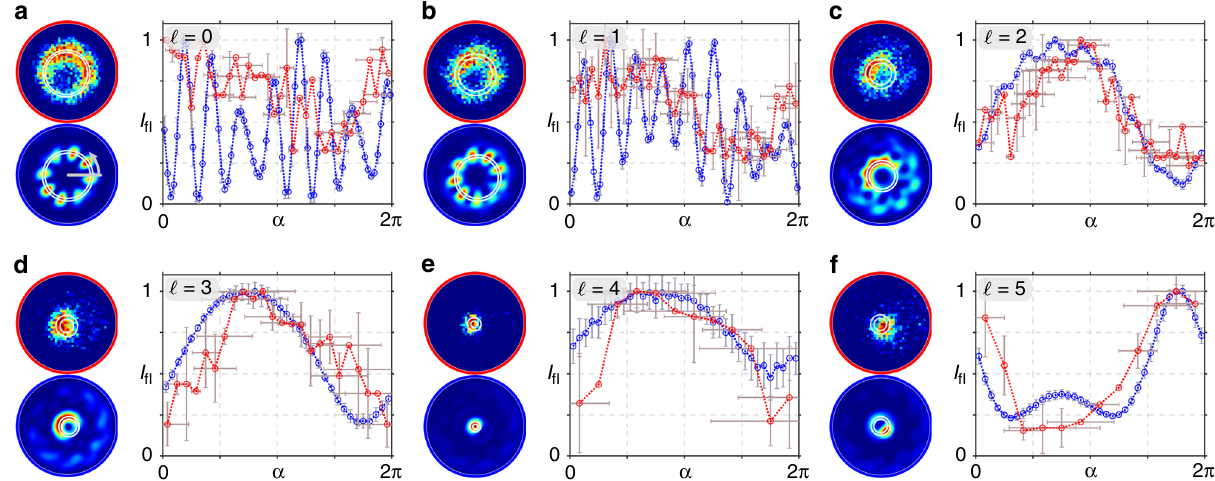
Fig. 7 Graphical analysis of fl uorescence for focused web con fi gurations. a – f σ 12 = − 8, ‘ ¼ f 0 ; 1 ; ¼ ; 5 g . Studied intensity images are shown to the left of each graph (experiment: red edged, simulation: blue edged). In graphs, the mean intensity I fl in an angular segment of a ring shaped subspace (white marks in intensity images) is shown in dependence of angular position α (red: experiment, blue: simulation). Intensity errors are given by standard deviation, experimental angular errors are calculated on the basis of the point spread function of the imaging